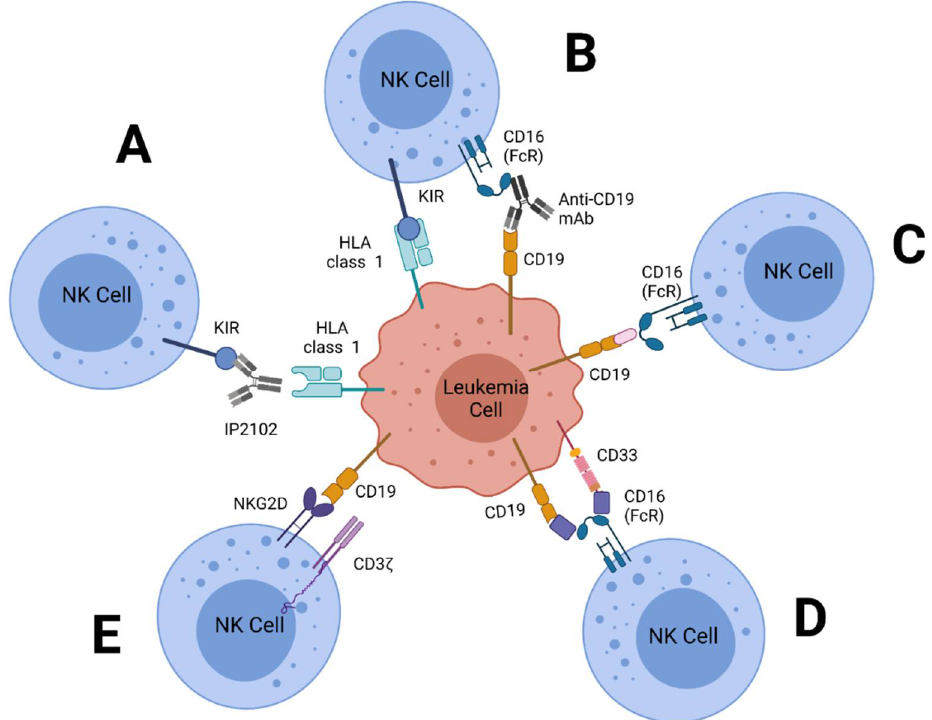
Figure 2. Mechanisms for increasing an NK cell response against tumor cells. ( A ) Blockage of KIR-HLA interactions by a monoclonal antibody (IPH 2102/lirilumab). ( B ) Inhibitory signals from KIR-HLA interactions are nullified by binding and activation of CD16 to monoclonal antibodies bound to CD19 antigens. ( C ) Activation of NK cells by a CD16xCD19 BiKE. ( D ) Activation of NK cells by a CD16 × CD19 × CD33 TriKE. ( E ) Utilization of CD19-recognizing CAR-NK cells with CD3 ζ /NKG2D transmembrane